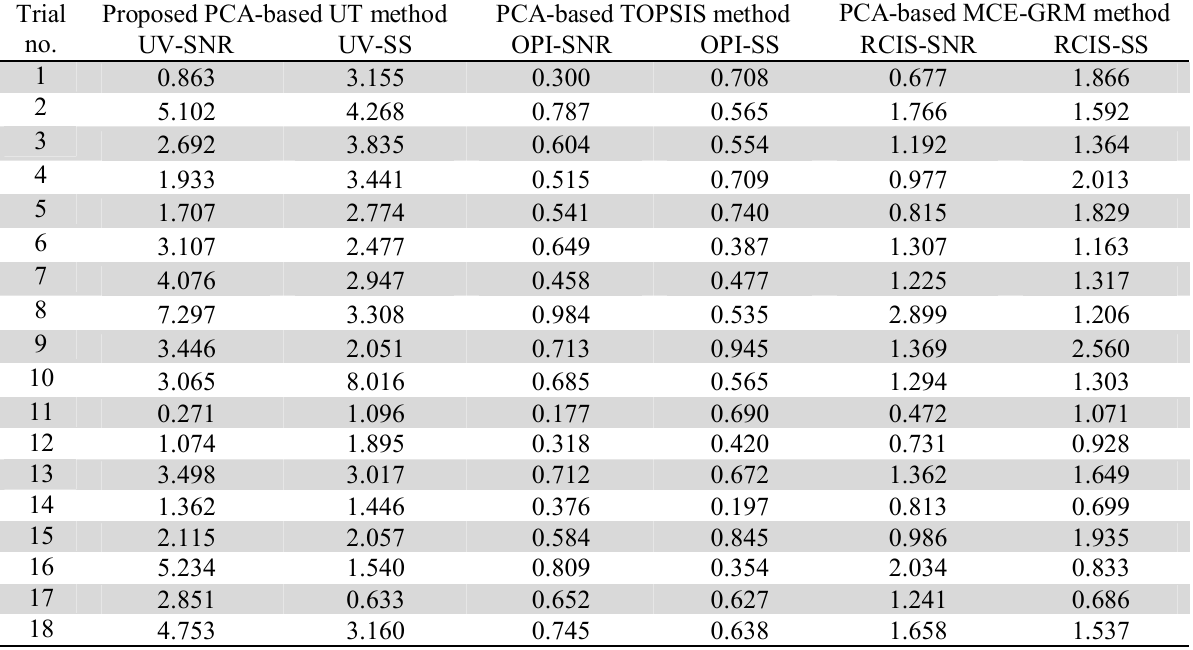
Results of ANOVA on UV-SRN and UV-SS, OPI-SNR, OPI-SS, RCIS-SNR and RCIS-SS (case study 1) Source 0.23